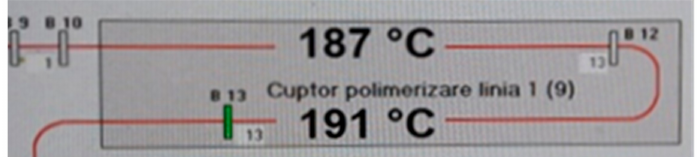
Figure 1. The polymerization process before